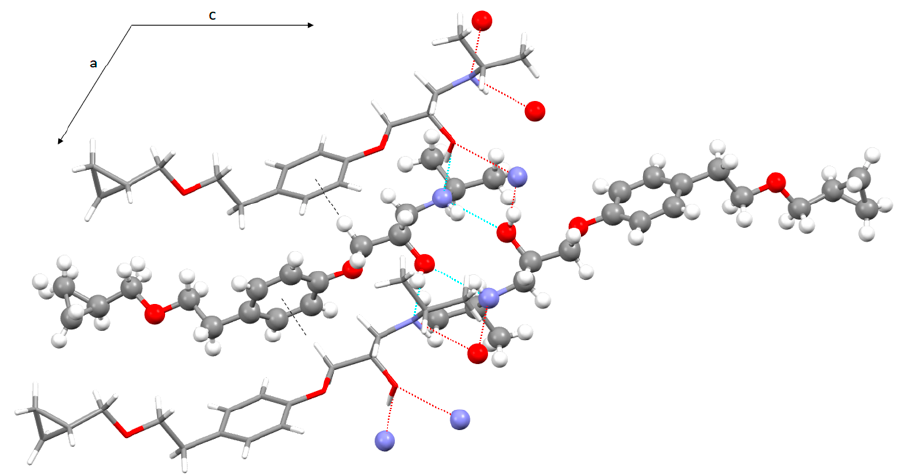
π Figure 5. View of the H-bond and CH ... π network in the crystal packing of BE_IV along the b axis Figure 5. View of the H-bond and CH … network in the crystal packing of BE_IV along the b axis direction (S enantiomer direction (S enantiomer in ball and stick, R enantiomer in stick). For sake of clarity only the set of in ball and stick, R enantiomer in stick). For sake of clarity only the set of coordinates having the highest occupancy factor coordinates having the highest occupancy factor was was shown.